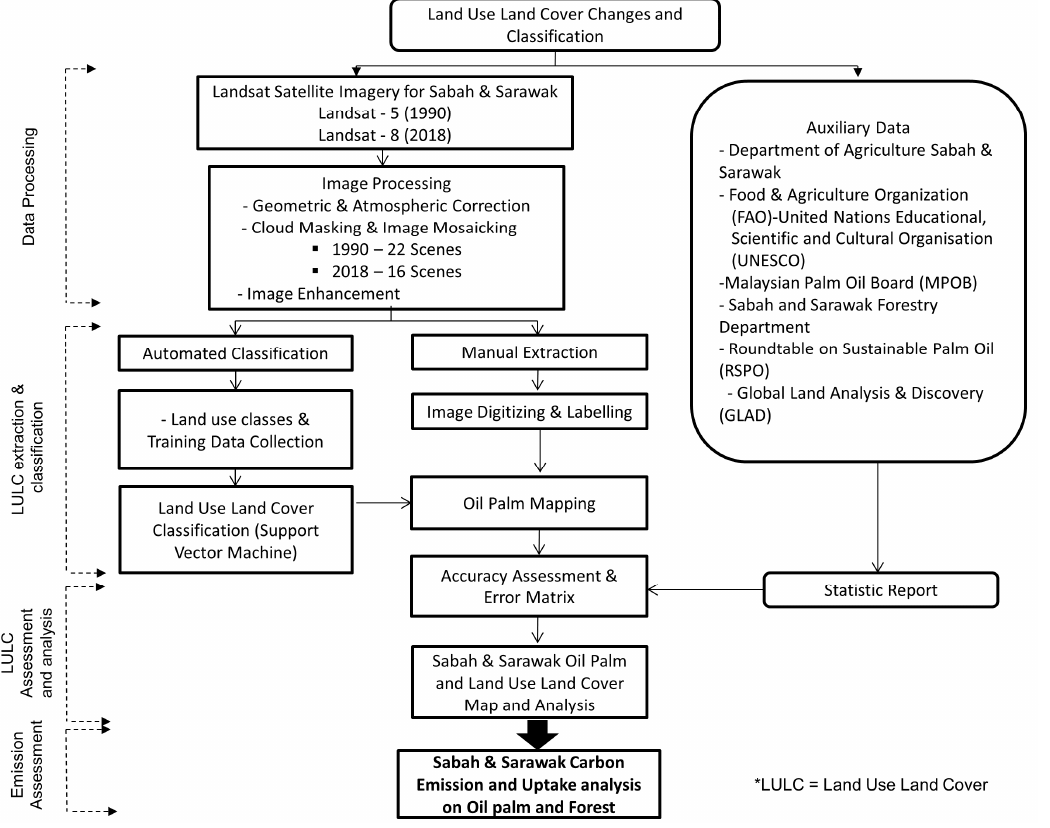
Figure 2. Flow chart demonstrating the workflow incorporated for land use and land cover extraction and classification.